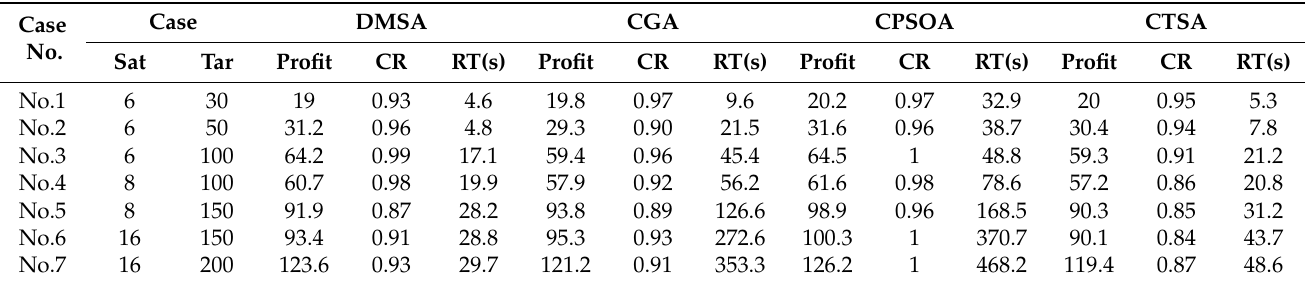
Table 3. Simulation results in different cases.